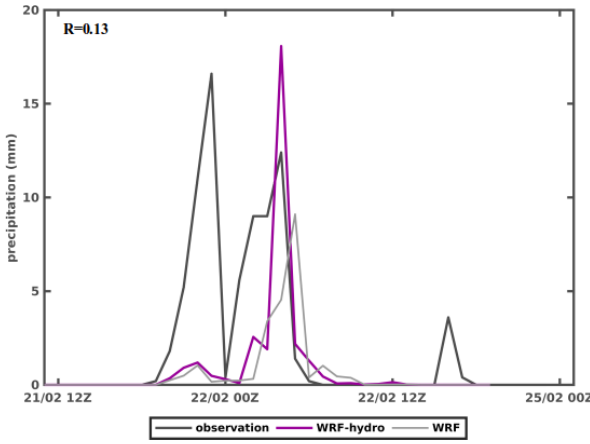
Figure 2. The temporal evolution of the precipitation at the rain gauge station at Vilia for event